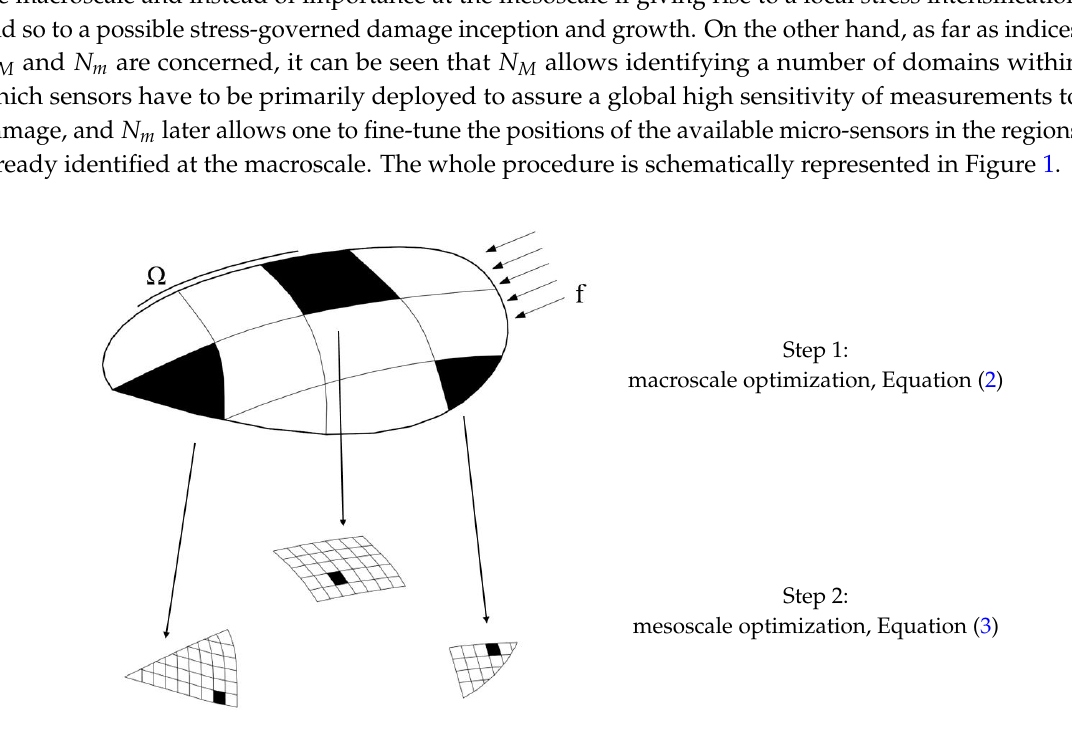
Figure 1. Graphical representation of the proposed optimization